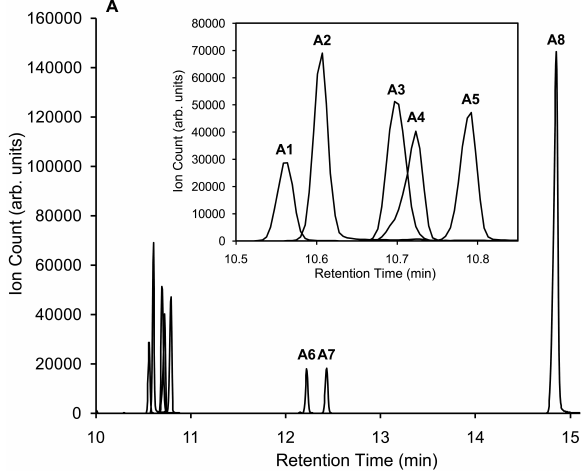
Fig. 2a. Chromatogram from a derivatized mixture of amines an- alyzed by GC/MS. Inset: expanded view of the peaks in the 10.5– 11.0 min range. (A1) , m/z 211, dimethylamine; (A2) , m/z 183, ammonia; (A3) , m/z 239, diethylamine; (A4) , m/z 225, ethyl- methylamine; (A5) , m/z 197, methylamine; (A6) , m/z 239, n - butylamine; (A7) , m/z 253, morpholine; (A8) , m/z 259, aniline.